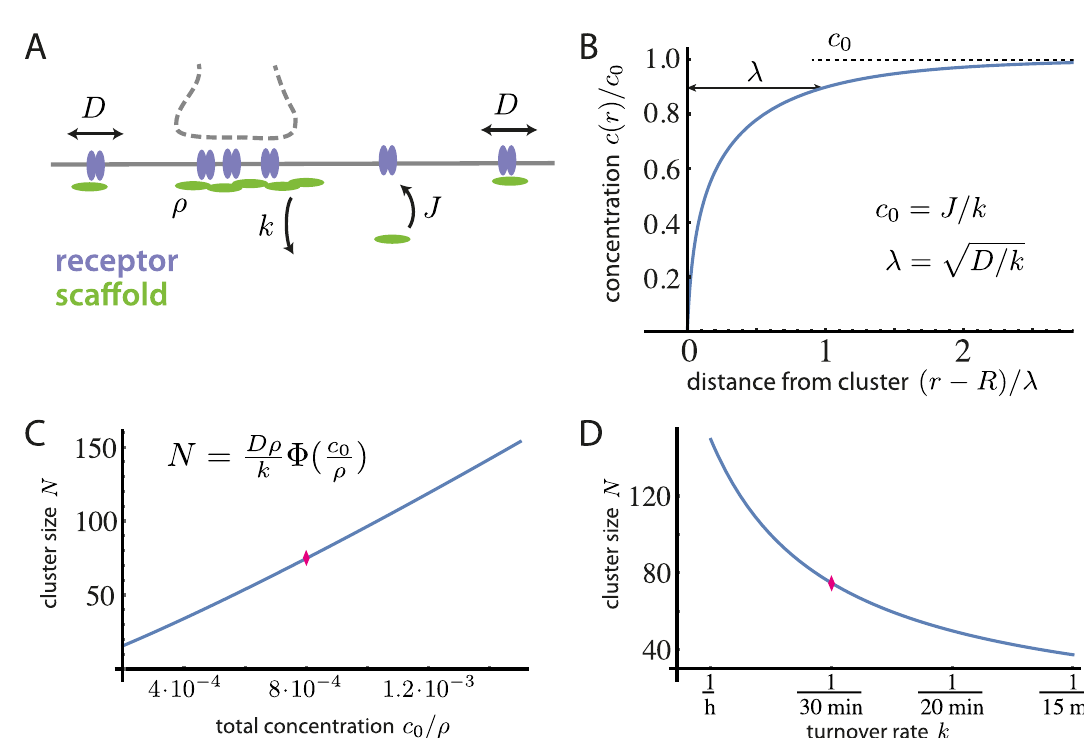
Fig 1. Lateral diffusion and aggregation of scaffold-receptor complexes at the post-synaptic membrane. A: Sketch of the model basic processes: receptors (GlyR, blue) and scaffold “particles” (gephyrintrimers, green) can form complexes; scaffold particlesare brought to the cell membranewith a flux J and leave it with a rate k ; sub-membraneousscaffold particles aggregateby homotypic scaffoldingprotein interactions; scaffold-receptor complexes diffuse laterally along the cell membrane, with a diffusion constant D . B: Concentration profile of diffusing scaffold particles arounda disc-shaped scaffold domainof radius R . Far from the cluster, the concentration of diffusing scaffold particles is uniform and equal to J / k . The ffiffiffiffiffiffiffiffiffi p D = k diffusingscaffold particles are depleted in a layer of size l ¼ close to the cluster boundary.C: Dependence of the stationary domain size N on the particle concentration c 0 . D: Dependence of N on the turnover rate k . Referenceparameters are taken to be D = 0.02 μ m 2 /s [16], k = 1/(30 min) [9], c 0 = 4/3 μ m − 2 [16, 27]. The concentration of scaffold particles/trimers in a post-synaptic domain is taken to be ρ = 5000/3 μ m − 2 [6]. When parameters are varied in B and C, the reference values are marked (red